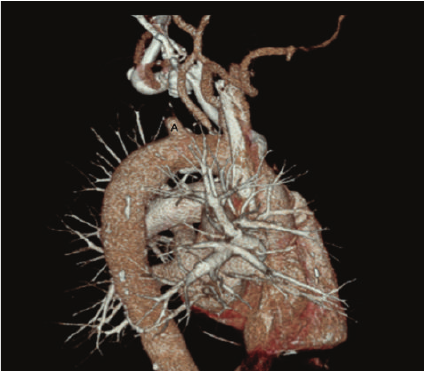
Figure 2: CTA of the chest with complete occlusion of left subcla- vian artery (A).